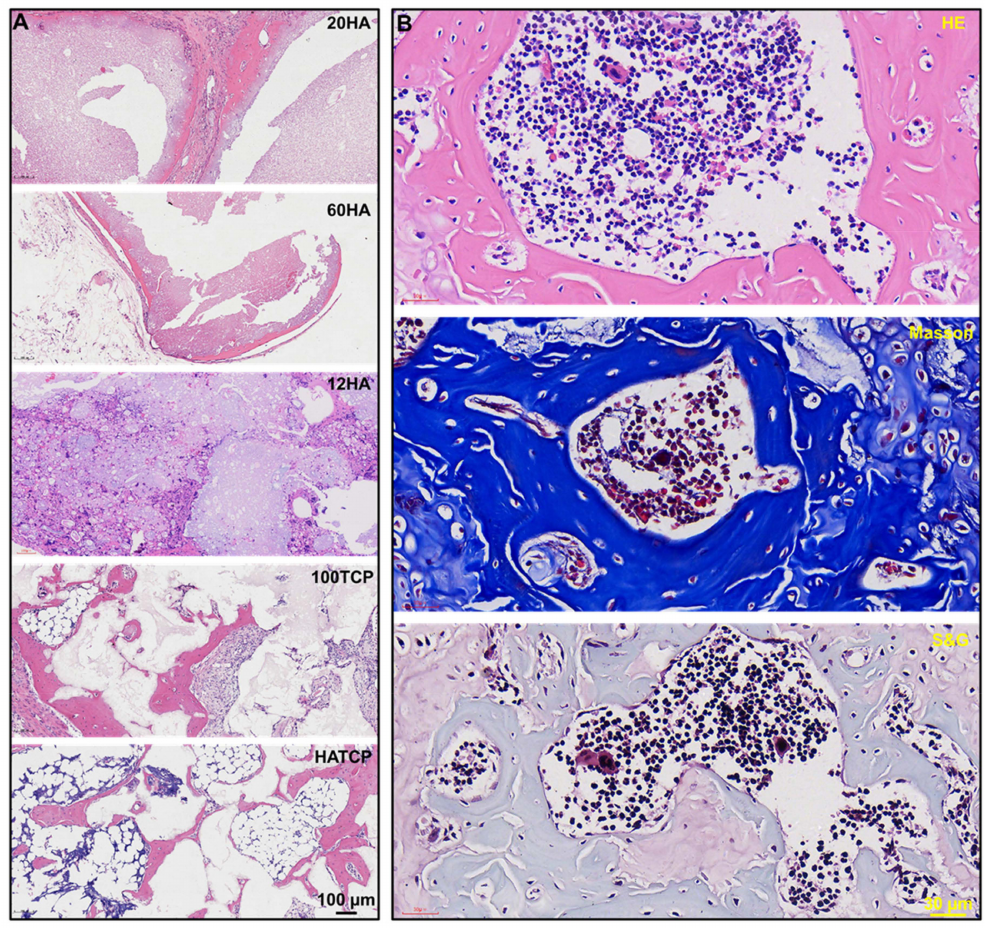
Figure 4. Osteoinduction of Ca-P biomaterials. ( A ) New-bone formation was observed in groups 20HA, 60HA, 100TCP and HATCP but not ingroup 12HA. Bar: 100 µ m. ( B ) HE, Masson’s and safranine–fast green stainings of group HATCP showed that new bone tissues were pink, blue and light green. Bar: 30 µ m.